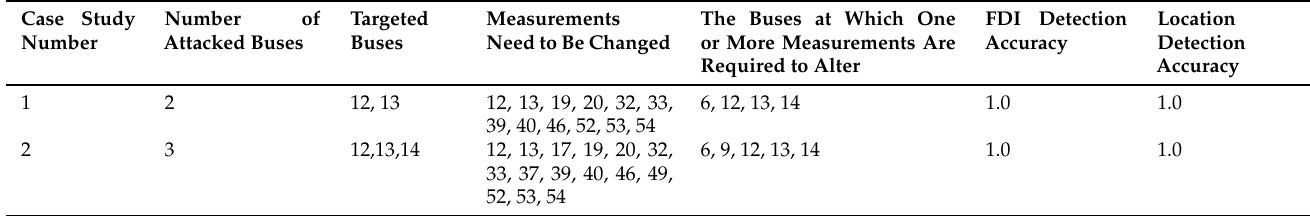
Table 10. Details about Case